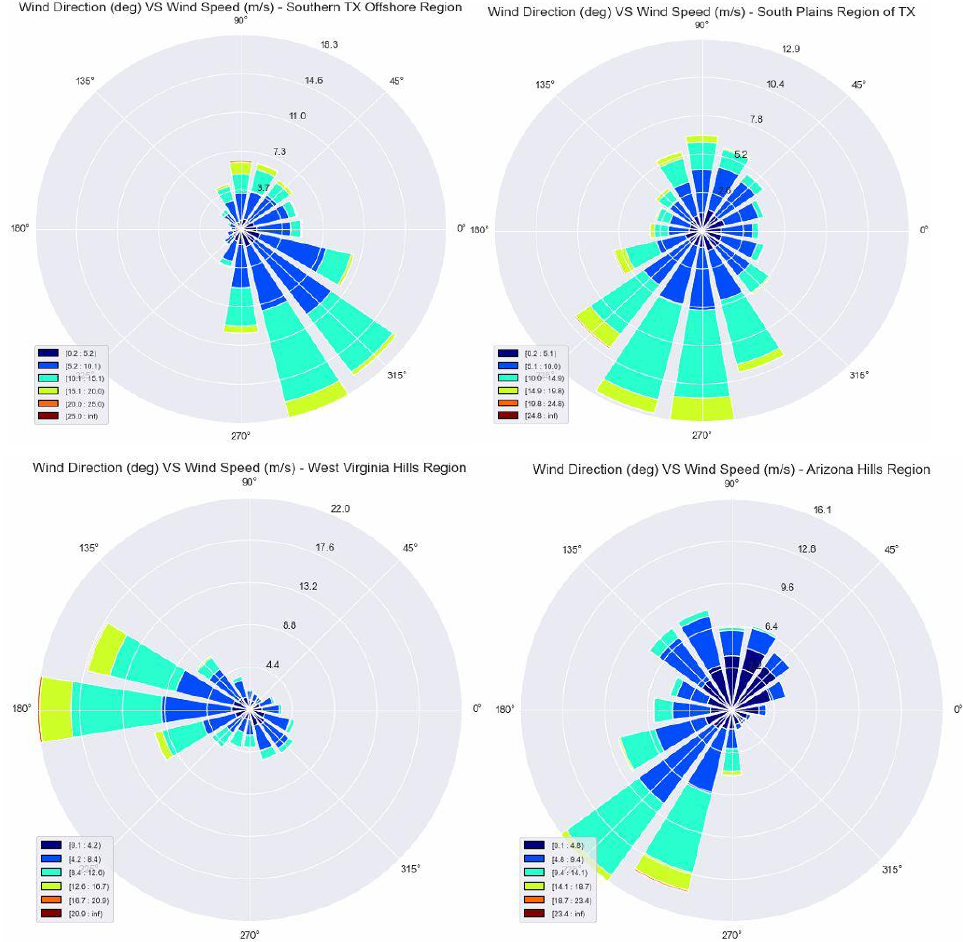
Figure 2. Distribution of wind speed and direction at four different